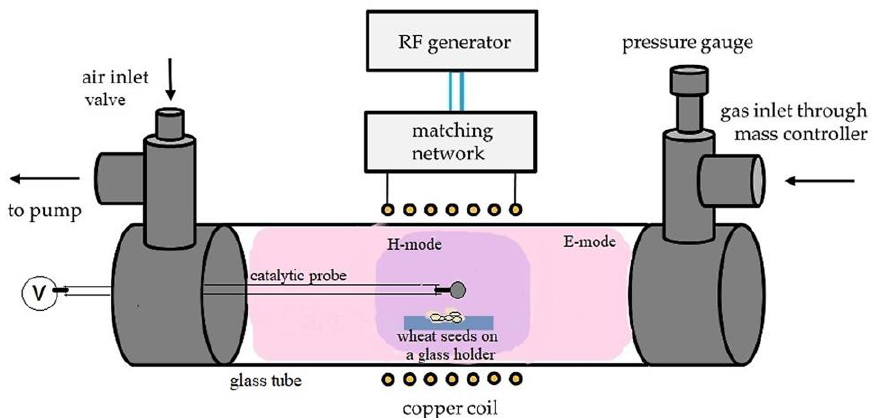
Figure 1. Schematic representation of the plasma system used for the treatment of wheat seeds. Adapted from [27] .